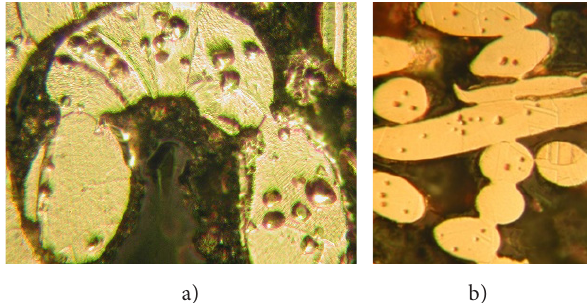
Figure 10. The effect of “hydrogen disease” on copper fiber bridges (a,